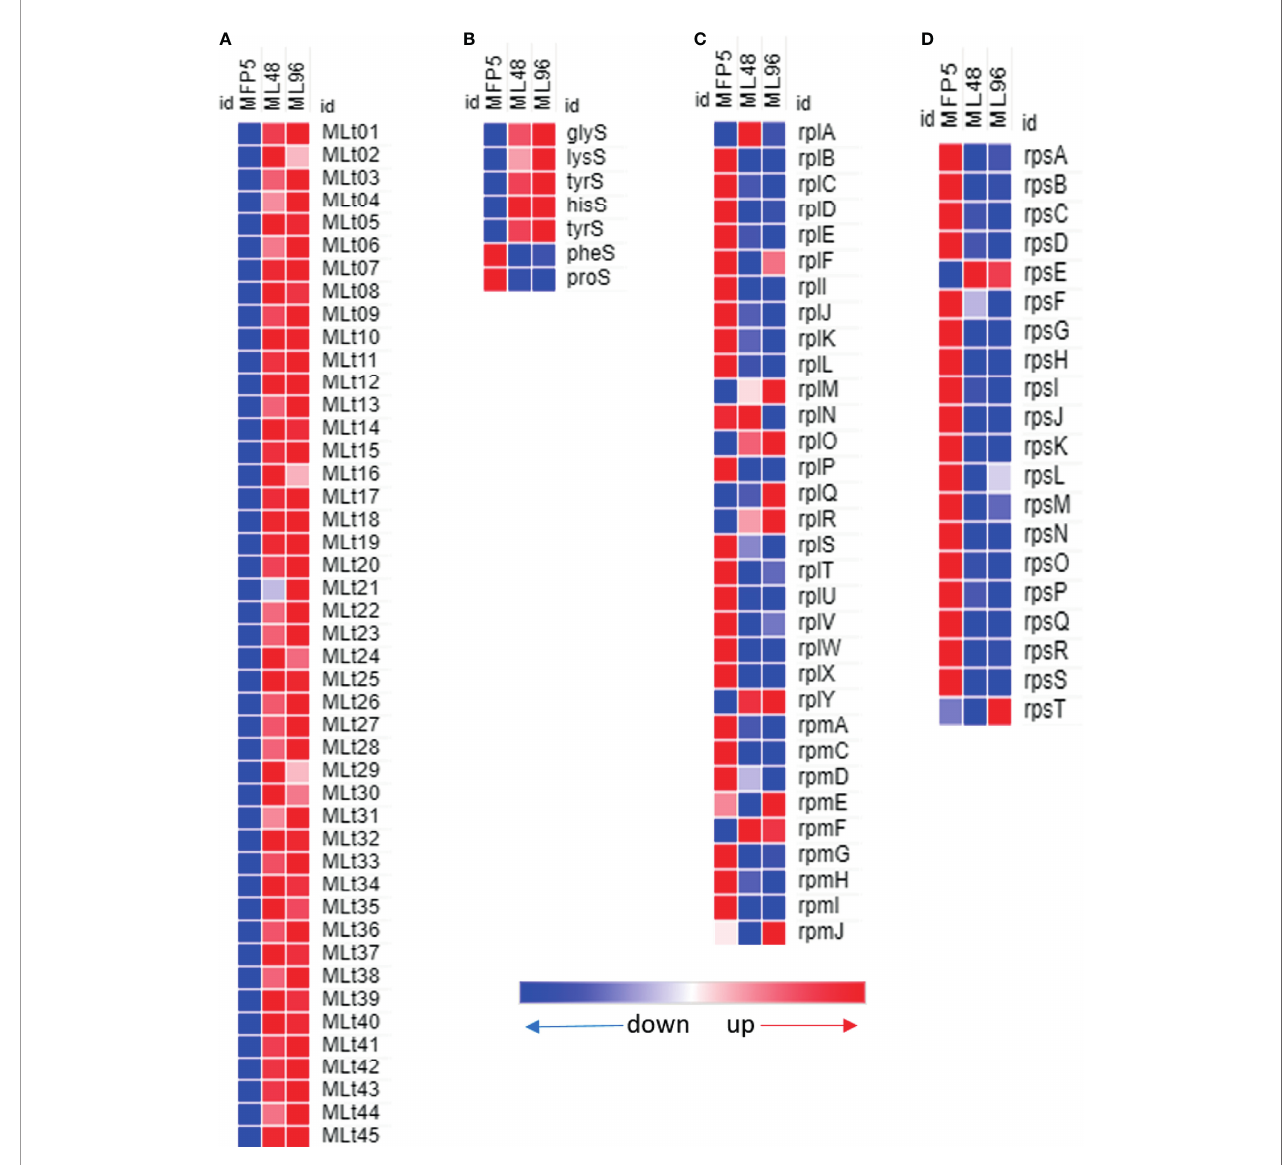
FIGURE 6 | Differential expression (average abundance) of M. leprae genes under in vivo (MFP5) and in vitro (ML48 & ML96) conditions. (A) transfer RNA, (B) transfer RNA synthetases, (C) 50S ribosomal proteins, (D) 30S ribosomal